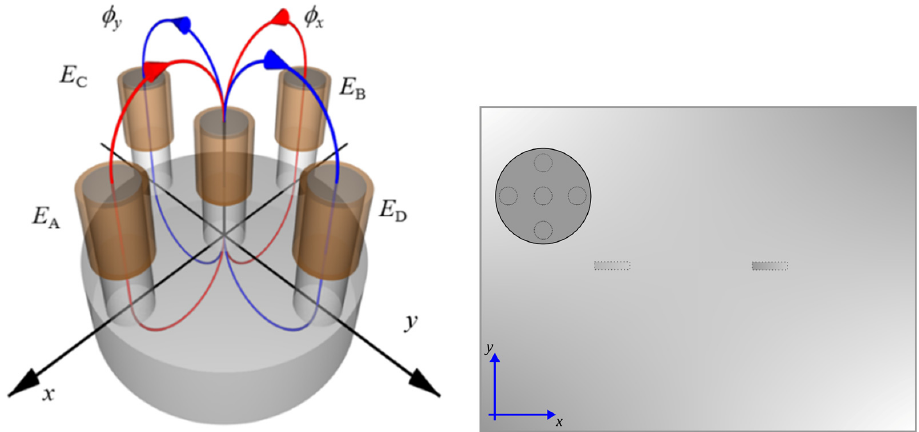
Figure 2. Schematic view of the differential eddy current transducer and arrangement over the sample. E A , E B , E C , E D — excitation coils, S— pick-up coil, core— ferrite core, φ x , φ y — magnetic fluxes generated by the pairs of excitation coils.